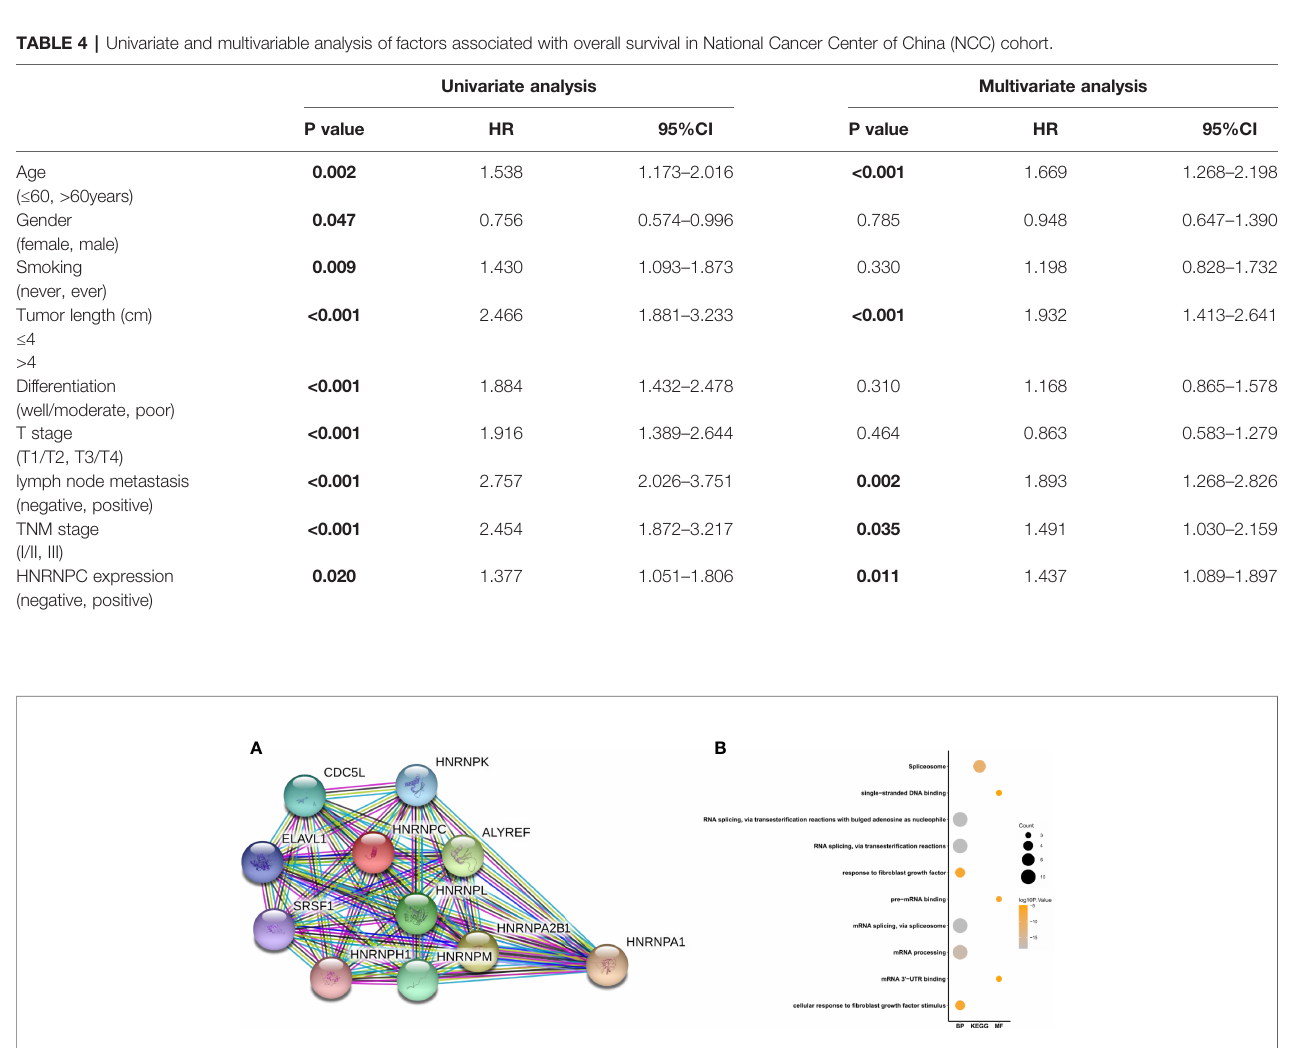
FIGURE 6 | Heterogeneous nuclear ribonucleoprotein C (HNRNPC)-related PPI network construction and biological function analysis. (A) PPI network constructed using 10 molecules (CDC5L, HNRNPK, ELAVL1, ALYREF, SRSF1, HNRNPL, HNRNPH1, HNRNPM, HNRNPA2B1, and HNRNPA1) signi fi cantly related to HNRNPC. (B) GO terms, including biological process (BP) and molecular function (MF), and KEGG pathways analysis. PPI, protein-protein interaction; GO, Gene Ontology; KEGG, Kyoto Encyclopedia of Genes and